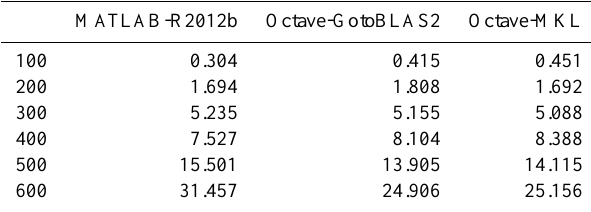
Table 4. Run time in seconds for different domain sizes for MAT- LAB (R2012b) and Octave version 3.6.4 (using GotoBLAS2 or MKL) for the primal algorithm with Cholesky